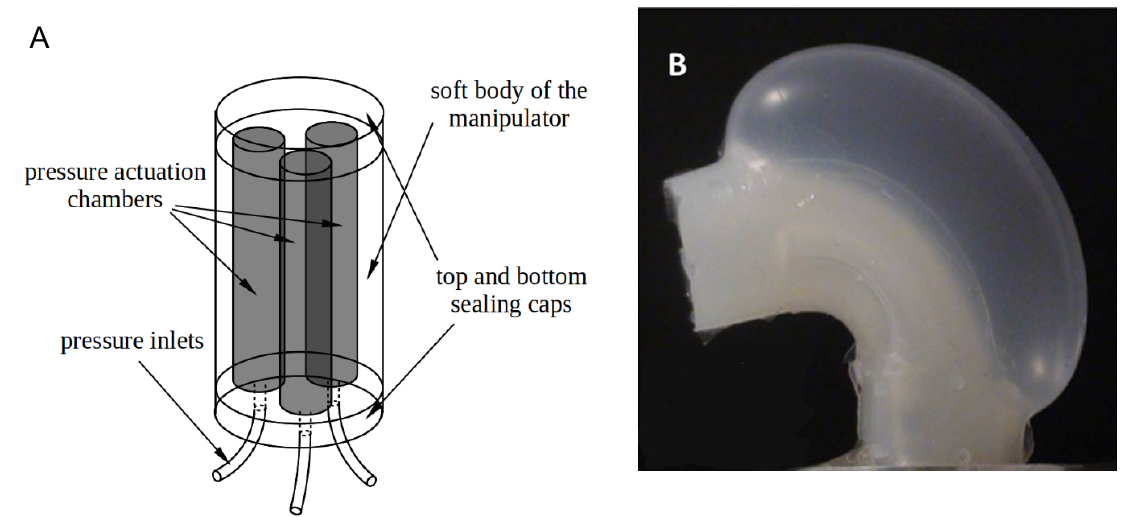
Figure 5. ( A ) Improved STIFF-FLOP arm design featuring three independent pneumatic actuators reinforced with fibres arranged around the central axis, embedded in a soft silicon body [28]; ( B ) Ballooning effect observed in a soft silicon structure upon inflating an embedded air chamber without fibre reinforcement [34].